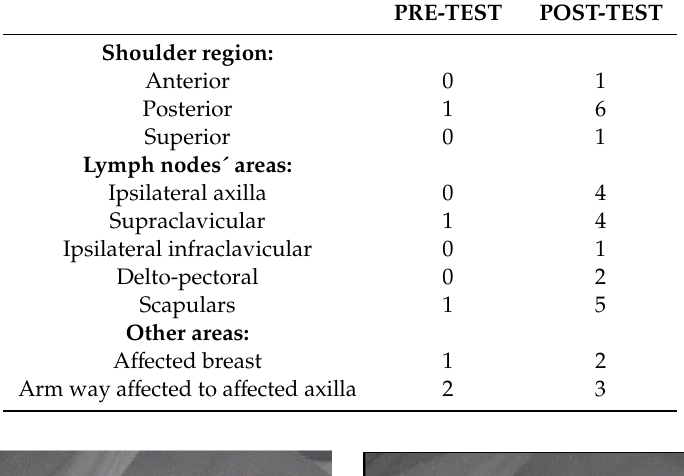
Table 1. Observations of the uptake of tracer in the pretest and posttest.